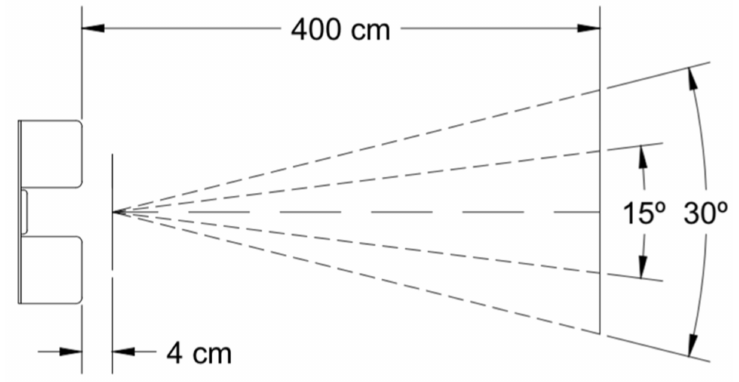
Figure 6. Range of the ultrasonic sensor.